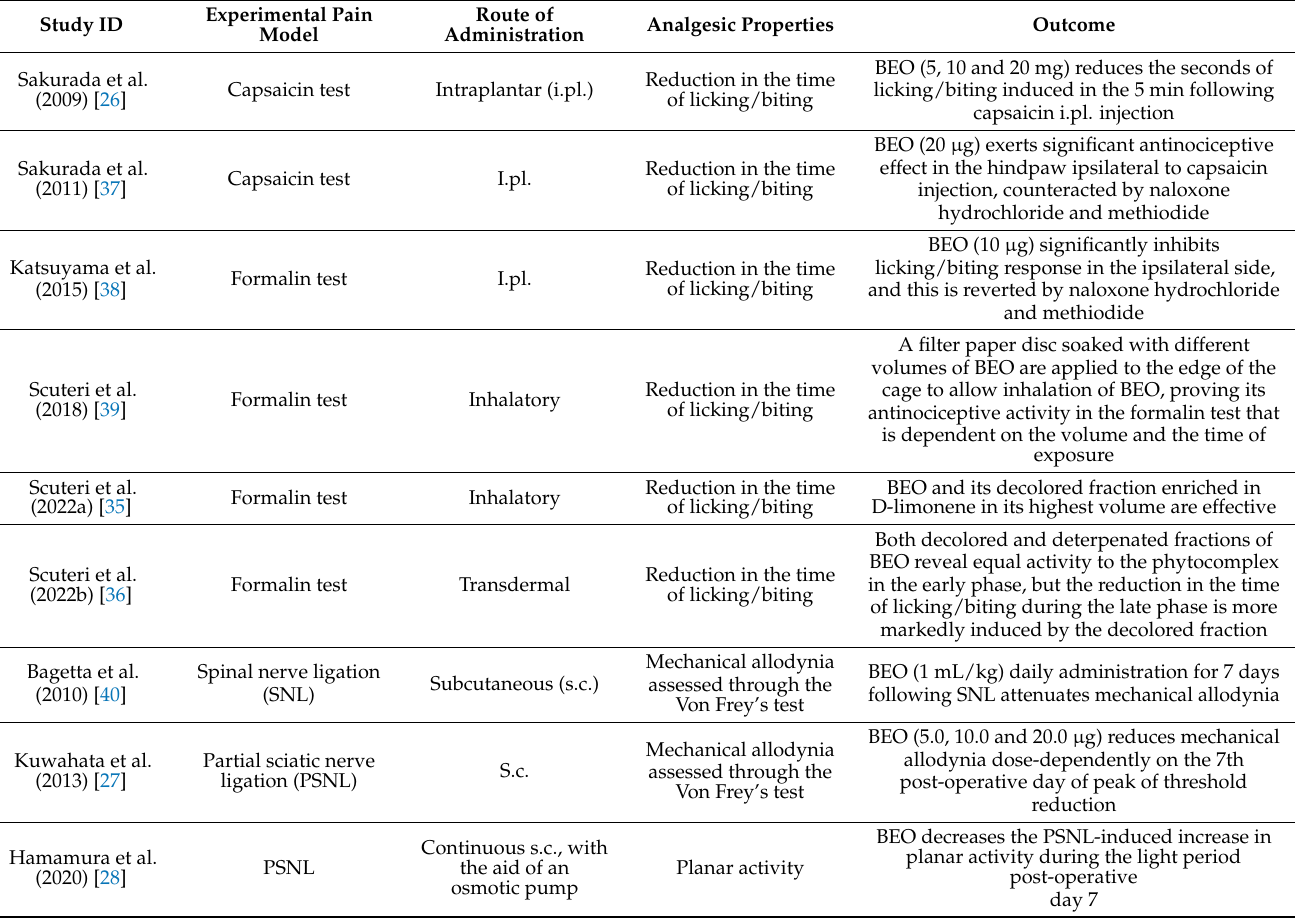
Table 2. Summary of the antinociceptive and antiallodynic properties of the essential oil of bergamot